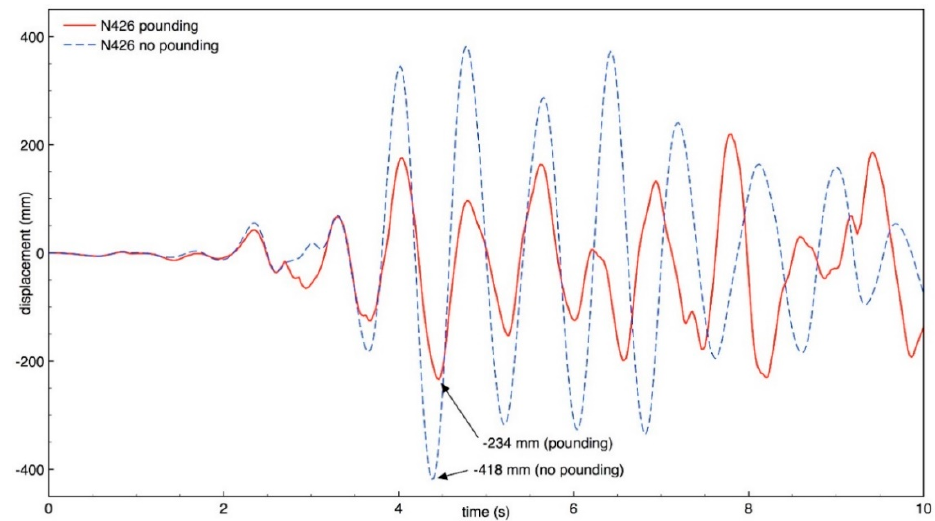
Figure 16. Longitudinal response of building B (node N426) with and without pounding.